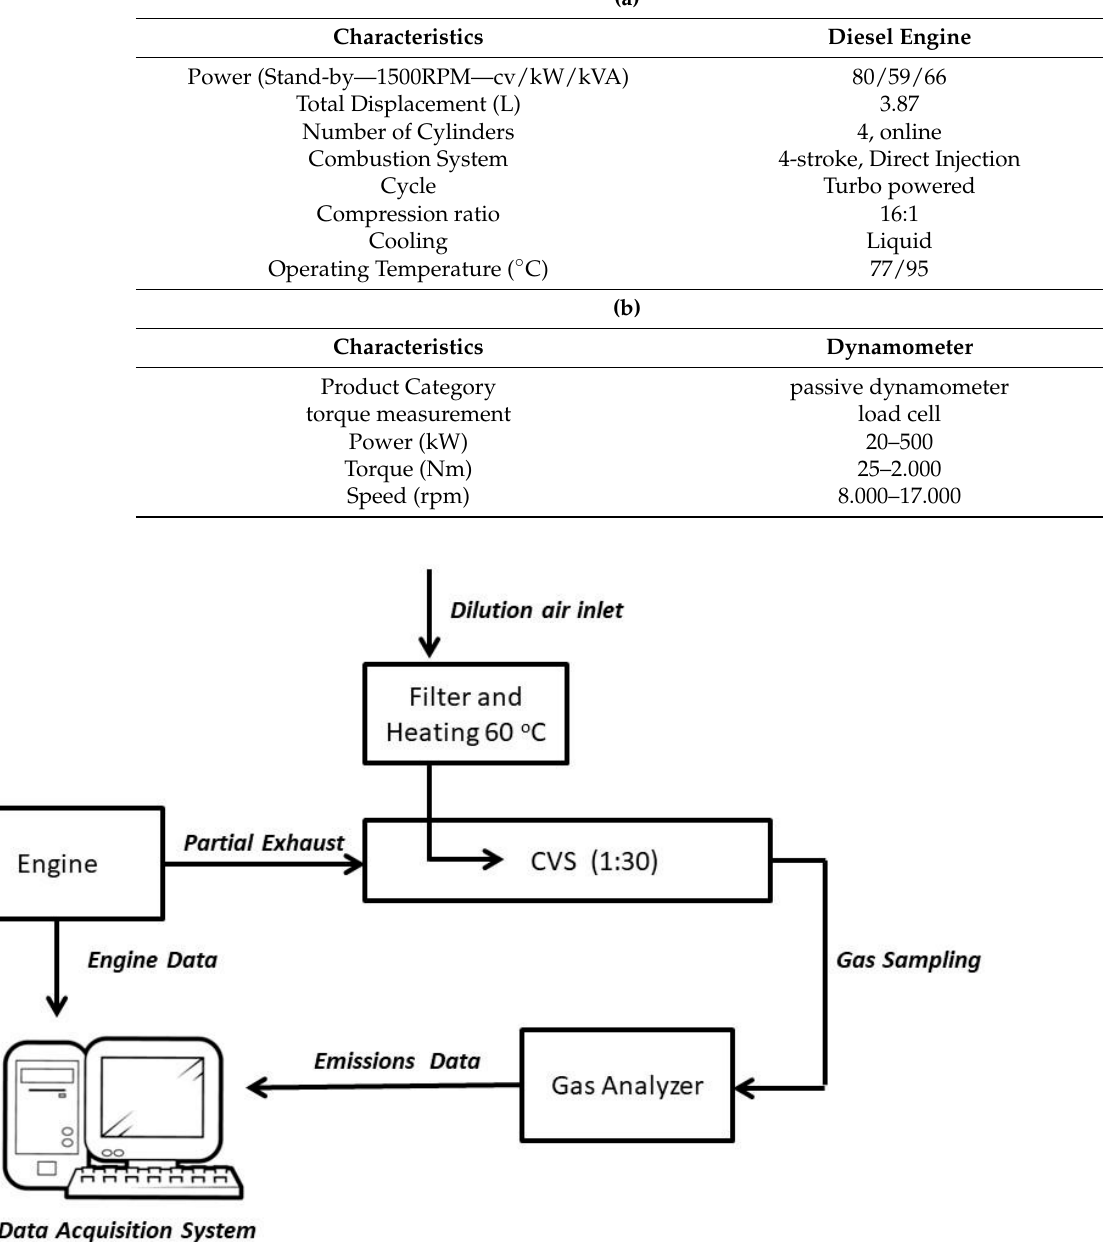
Figure 1. Schematic layout of the engine test bed and sampling system for PM 1.0 and PM 2.5.